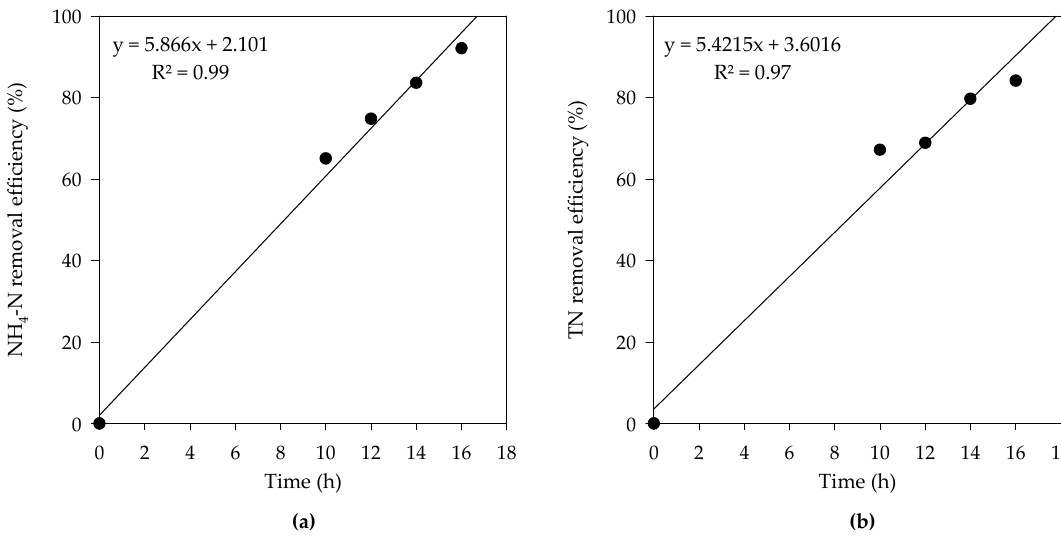
ffi ciencies in electrochemical Figure 6. Time lapsed ( a ) NH 4 -N and ( b ) TN removal efficiencies in electrochemical treatment. Figure 6. Time lapsed ( a ) NH 4 -N and ( b ) TN removal e